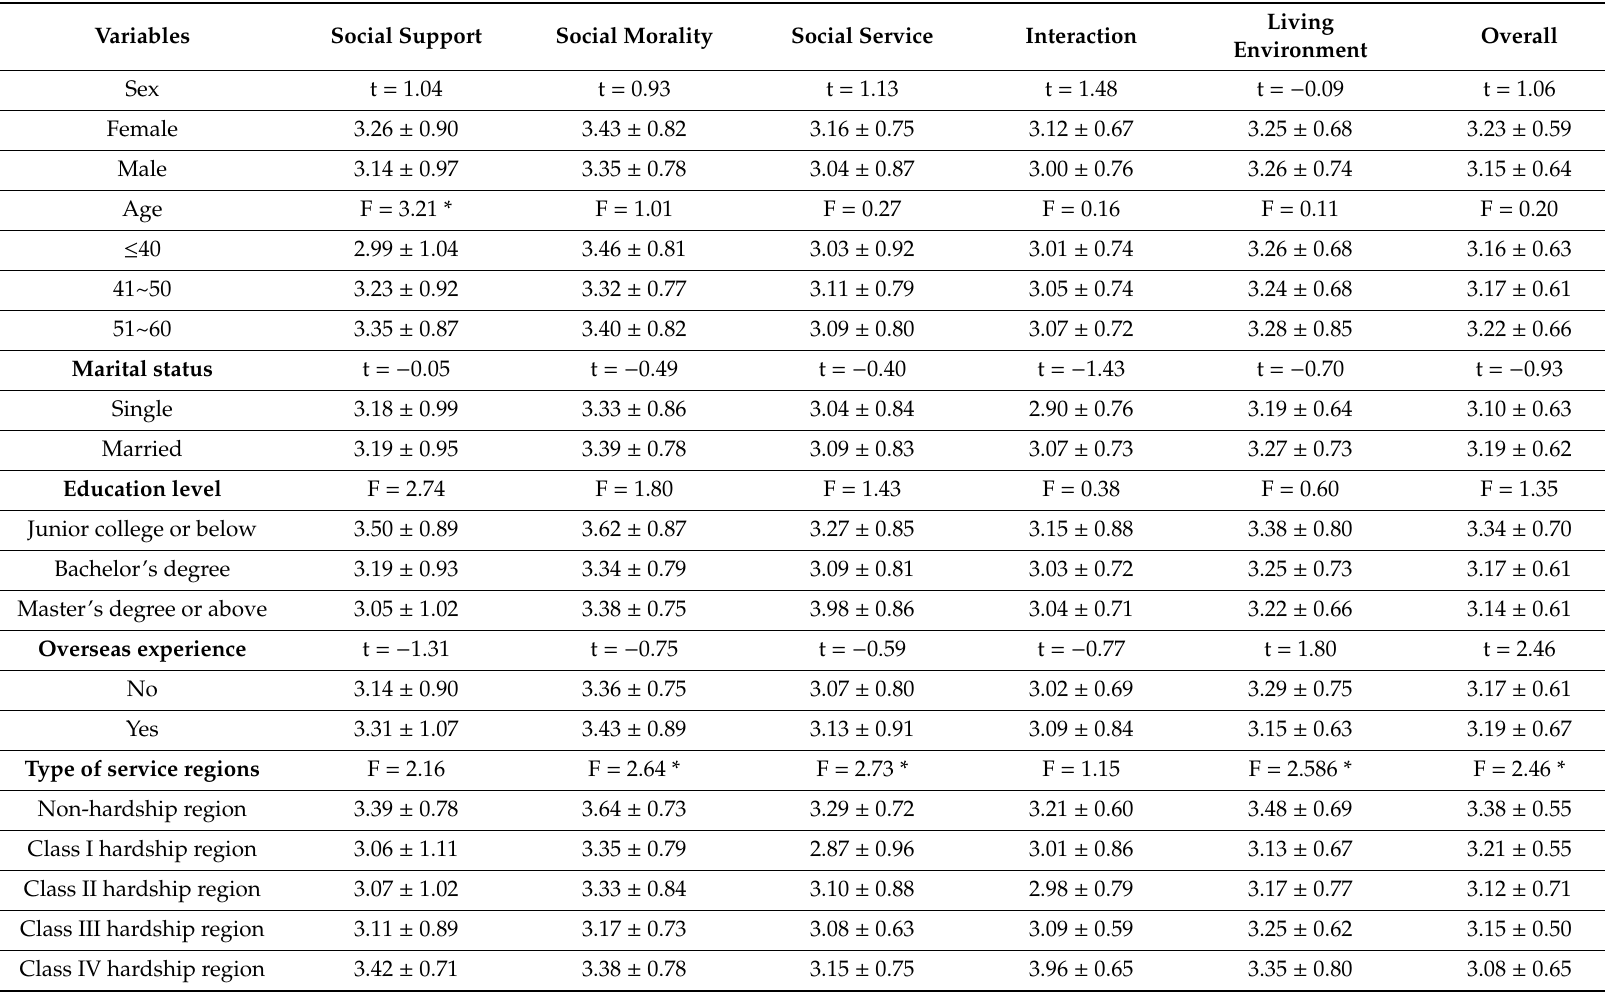
Table 3. Single related factors of overall socio-cultural adaptation and adaptation of each